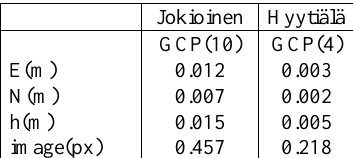
Table 1. Accuracy (RMSE) of ground control point positions from results of post-processing bundle adjustment using Agisoft PhotoScan.